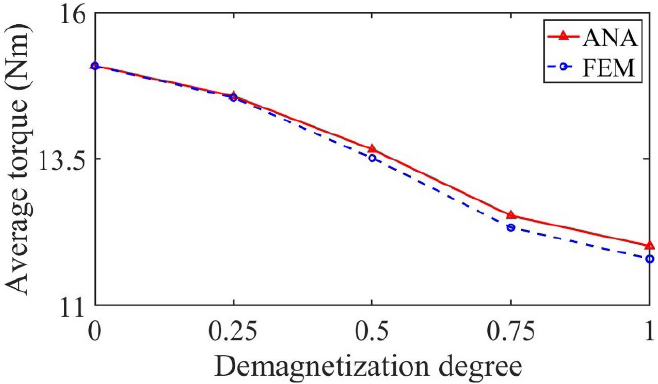
Figure 16. Variation in the average torque with demagnetization degree.